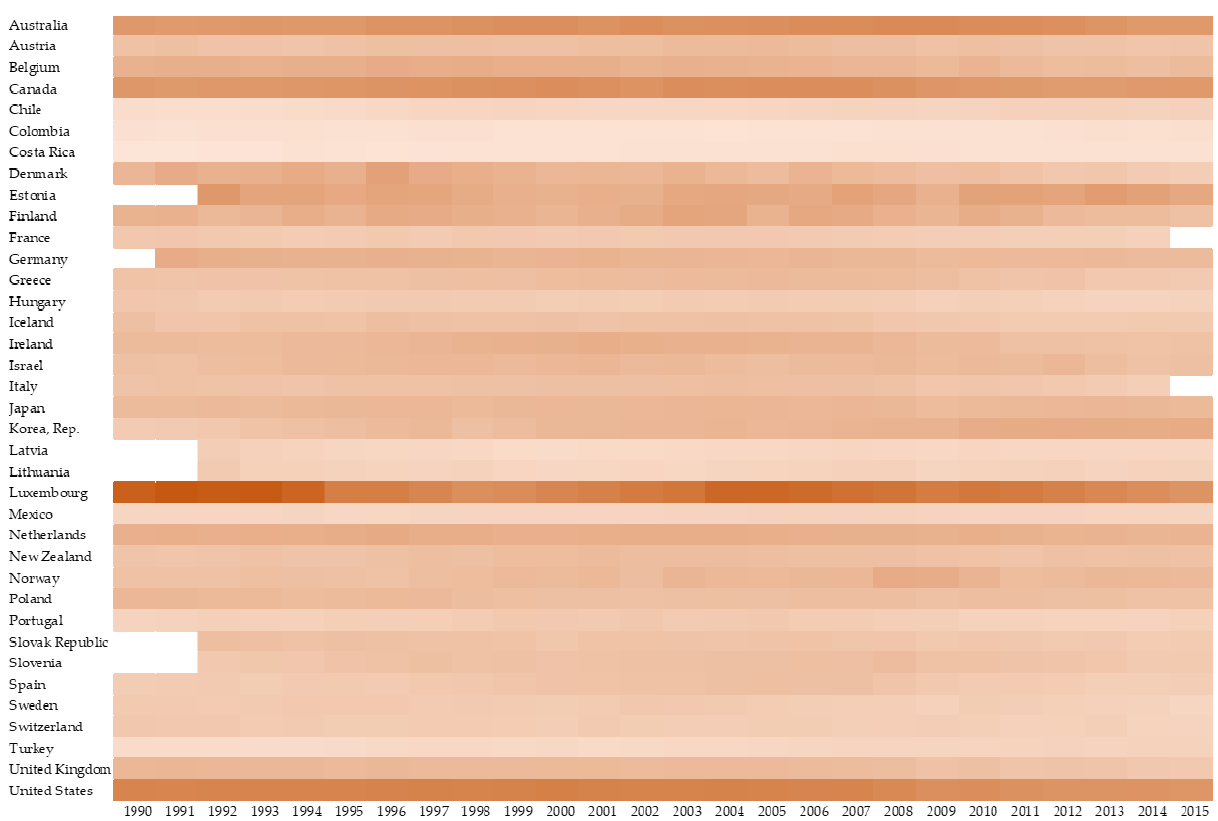
Figure 2. The heat map of REO for 37 OECD countries.